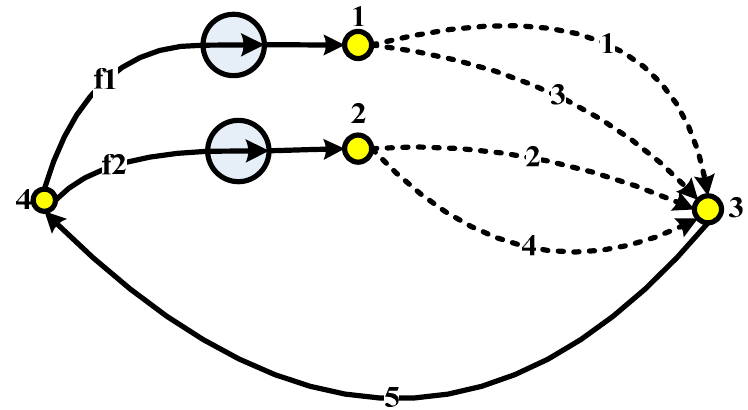
Figure 9. FFN of the nuclear-solar hybrid energy system (HES).